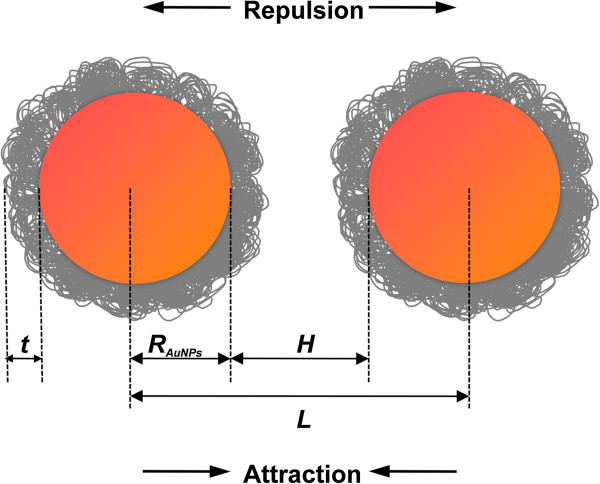
Schematic of two neighboring AuNPs coated with adsorbed PEG. RAuNPs is the radius of the AuNPs, L is the nanoparticle center-to-center separation distance, H is the separation distance between the nanoparticle surface (H = L − 2RAuNPs), and t is the thickness of the adsorbed PEG layer.